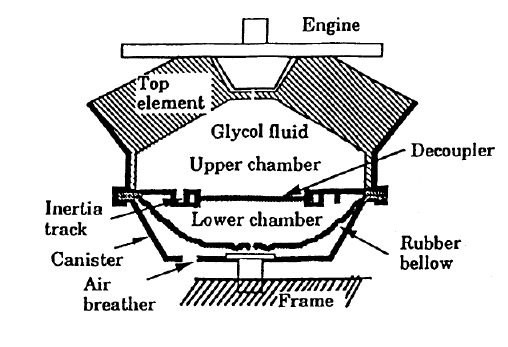
Fig. 3. Schematic diagram of a simple hydraulic mount with inertia track and decoupler [6].